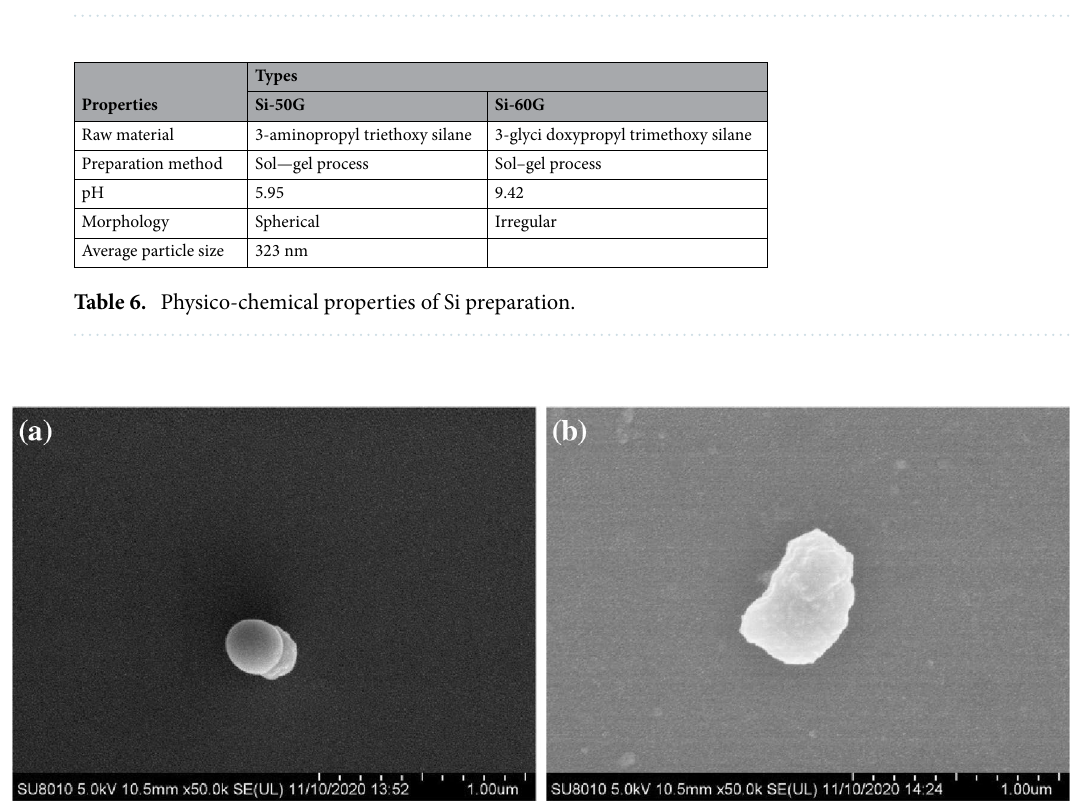
Figure 5. ( a ) shows the distribution of the main elements on the surface of the sphere; ( b ) shows the distribution of P; ( c ) shows the elements detected on the surface of the spheres by EDS.